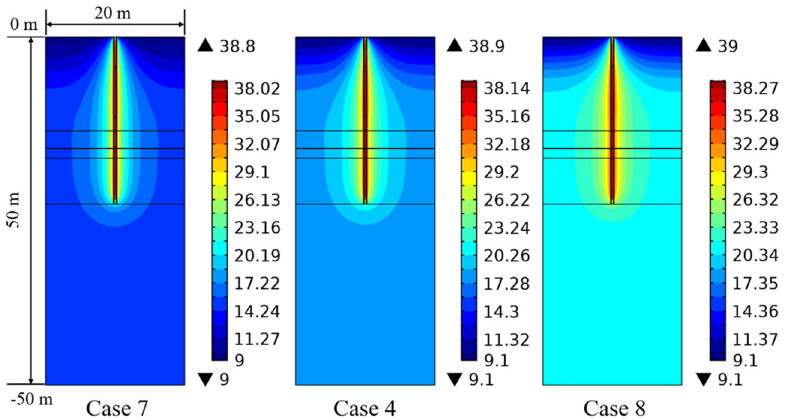
Figure 16. Effect of initial ground temperature on the ground temperature variation at 90 days (Units °C).